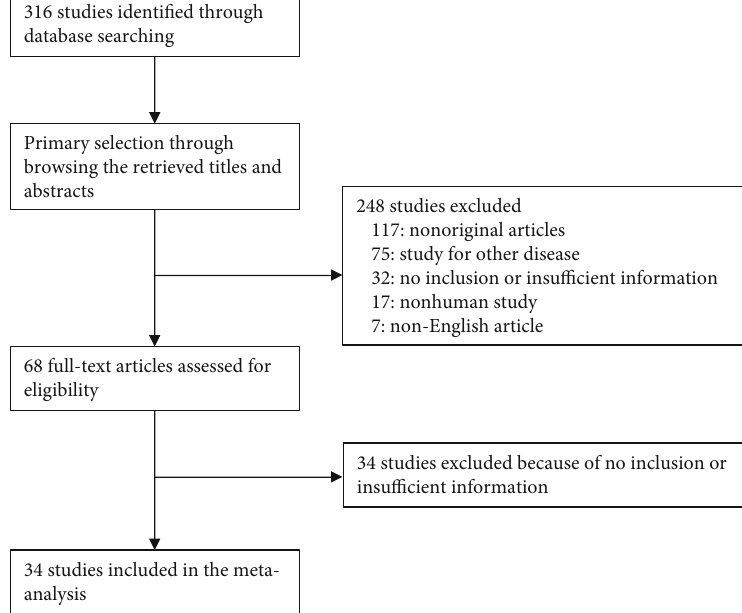
Figure 1: Flow chart of study search and selection